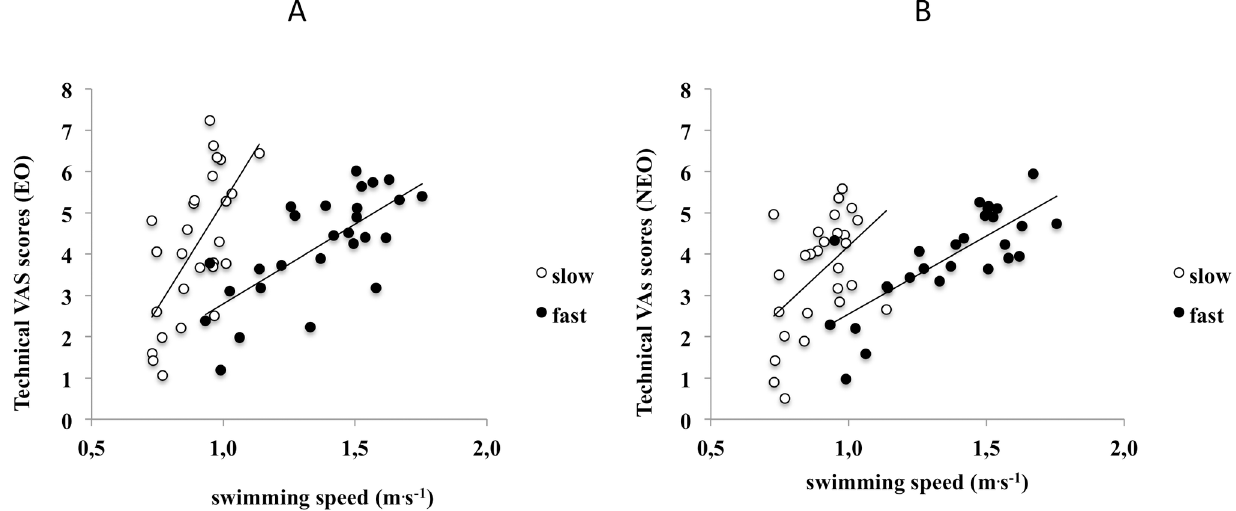
Fig 5. A and B: Relationship betweenVAS technicalcomponentscores and swimming speed(m , s -1 ) at slow (open dots) and fast (full dots) pace for expert observers (Panel A) and non-expertobservers (Panel B).